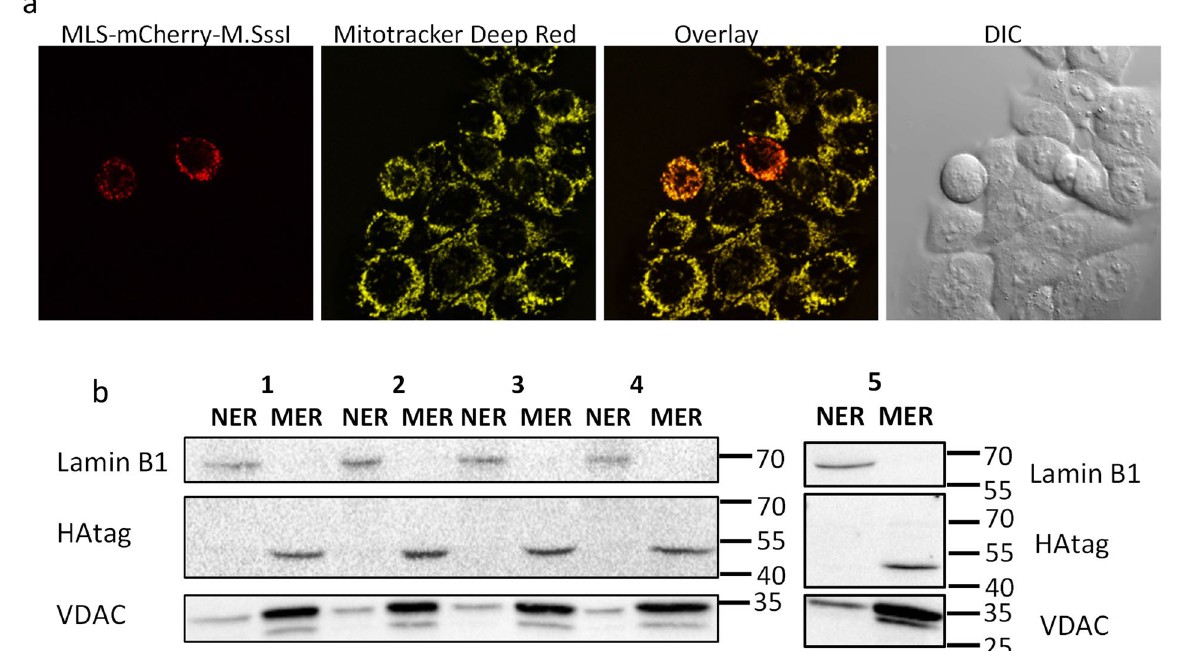
Figure 4. Mitochondrial localization of mitochondria-targeted DNA methyltransferases. ( a ) Confocal microscopy of HCT116 cells expressing MLS-mCherry-M.SssI. In order to stain the mitochondria, cells were incubated at 37 °C for 30 min. with 100 nM Mitotracker Deep Red. ( b ) Western blot of mitochondria-targeted M.CviPI, M.SssI or the catalytically inactive M.SssI ∆∆ . Mitochondrial (MER) and nuclear (NER) protein extracts were isolated from C33A cells expressing mitochondria-targeted M.CviPI (lane 1) or M.SssI (lane 5) and HCT116 cells expressing mitochondria-targeted M.CviPI (lane 2), M.SssI (lane 3) or M.SssI ∆∆ (lane 4). A HAtag antibody was used to recognize the mitochondria-targeted constructs in the MER (49 kDa for M.CviPI, 52 kDa for M.SssI) or NER. Inside the mitochondria the mitochondrial-localization signal is cleaved off, reducing the size of the protein with 5 kDa. VDAC1/Porin (32 kDa) and Lamin B1 (68 kDa) were used as mitochondria and nuclear loading controls,